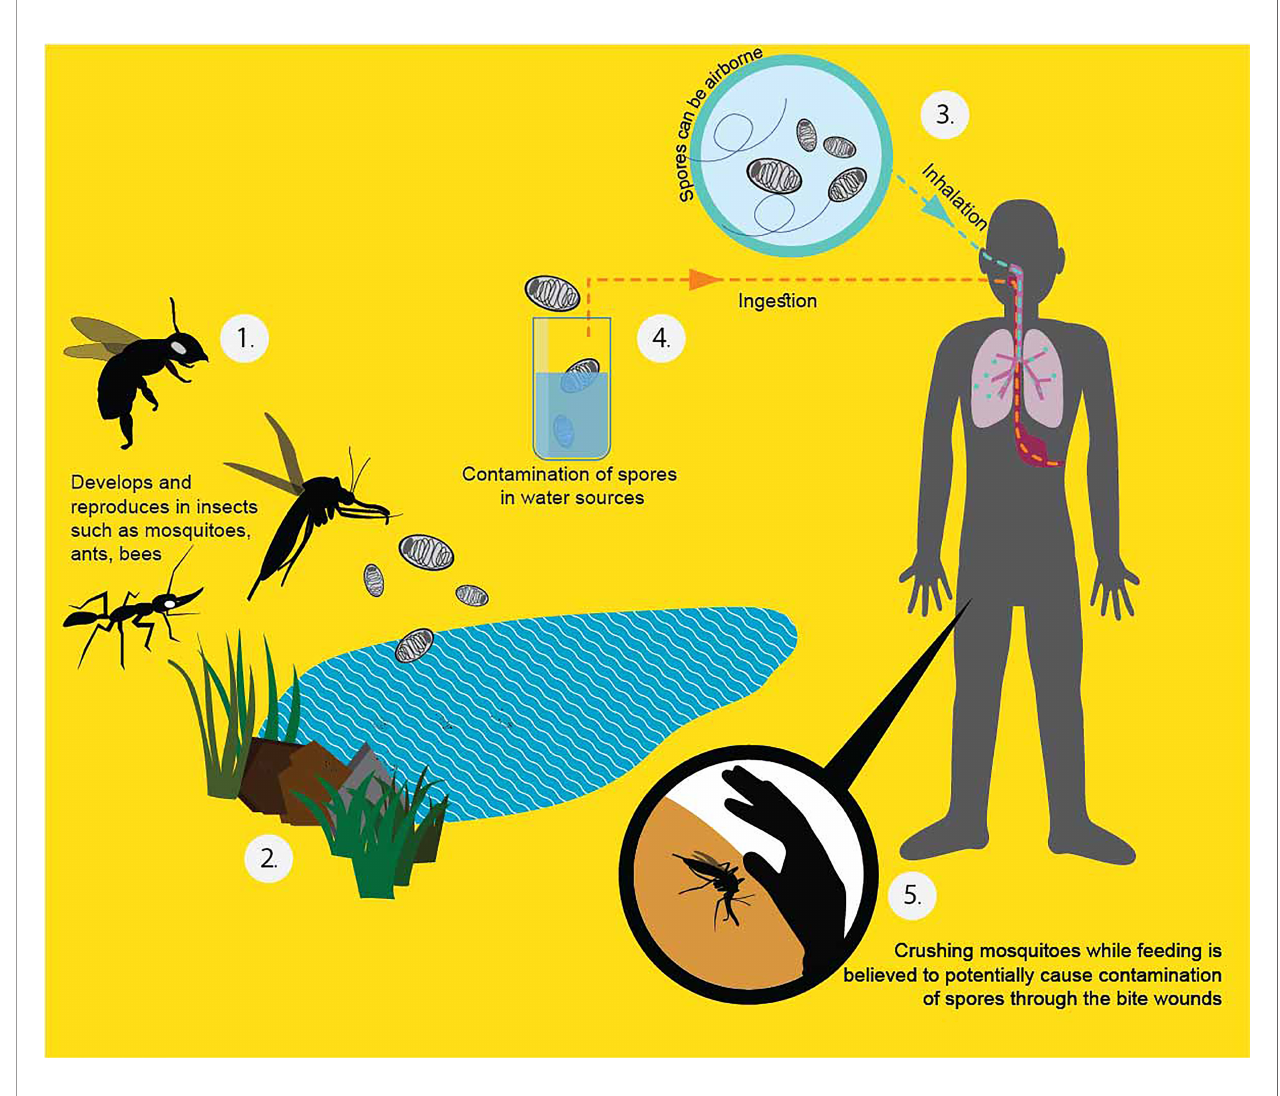
FIGURE 2 | Proposed T. hominis transmission in human beings (Heinz et al., 2012; Becnel and Andreadis, 2014; Watson et al., 2015). From the literature, the infected potential hosts can pass the spores with their secretion or feces. The dead bodies, once decay, can also release the resistant spores to the surroundings (1). The spores can persist outside for a long time because of the protective chitin shell (2). When a healthy host ingests the spores from the environment, they become infected. People can get the spores by inhalation (3), ingestion of contaminated water (4), and directly crushing the affected insect into the bite wound